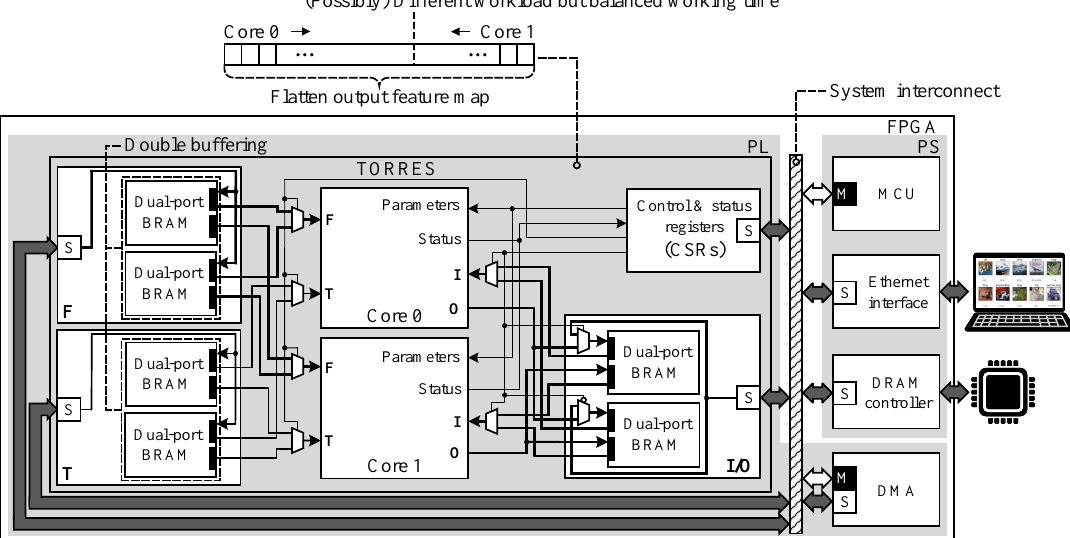
Figure 7. Prototype inference system, where PS, PL, M, and S stand for the MCU-based processing system, programmable logic, master, and slave interfaces,